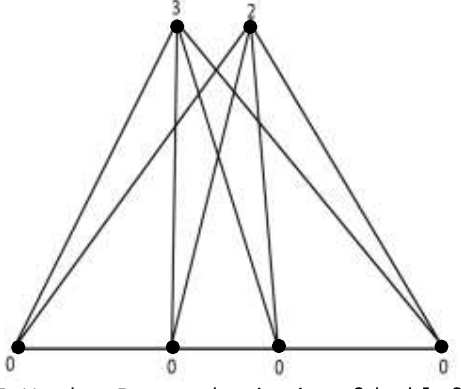
Figure 5: Modern Roman domination of double fan